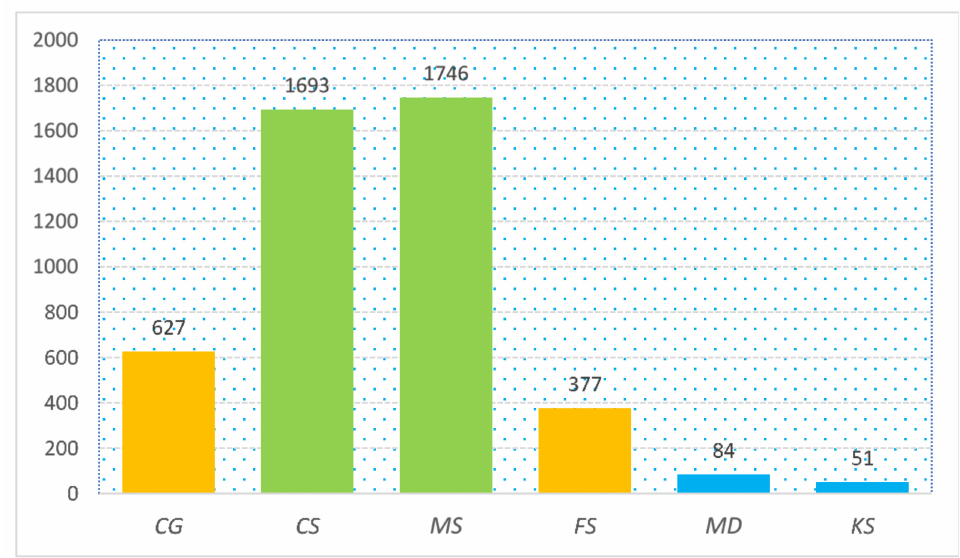
Figure 8. Lithology histogram of the Tarangaole